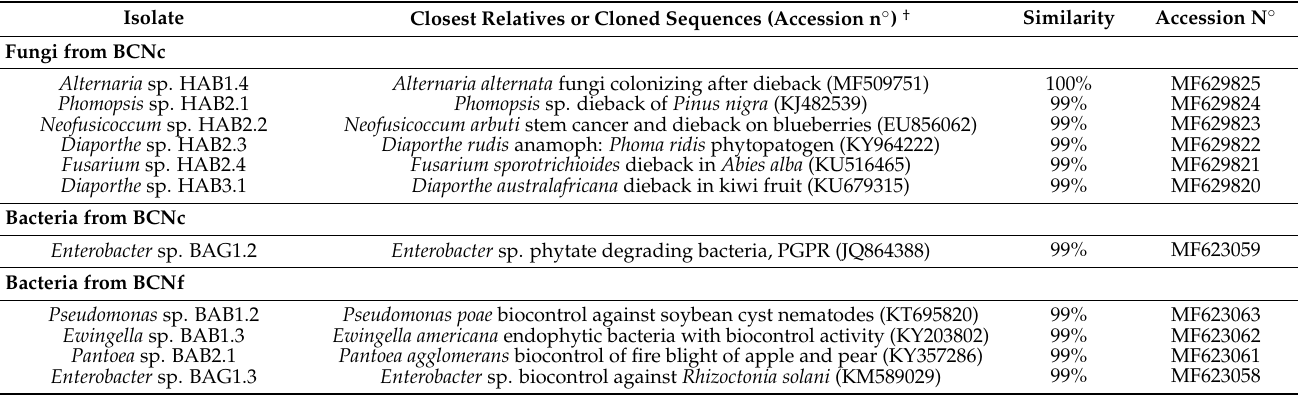
Table 5. Phylogenetic affiliation of isolates based on partial sequencing of ITS2 and 16S rRNA